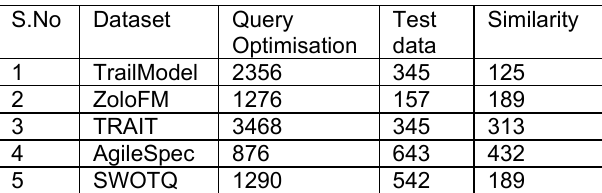
Table 1. The dataset from Amazon Redshit with query